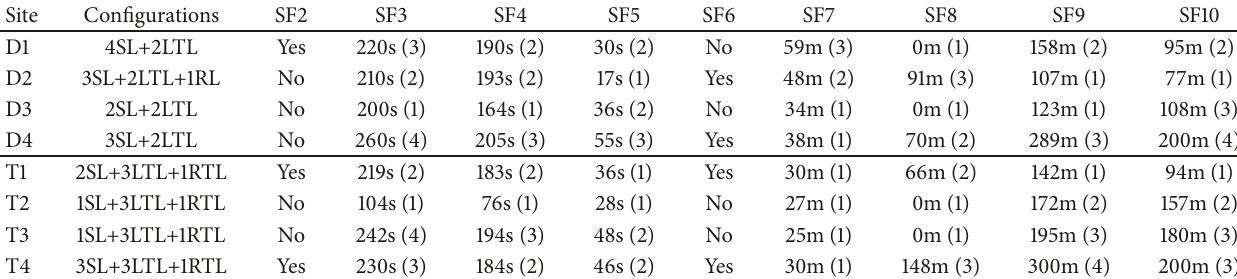
Table 5: Values of static influential factors at the study sites.